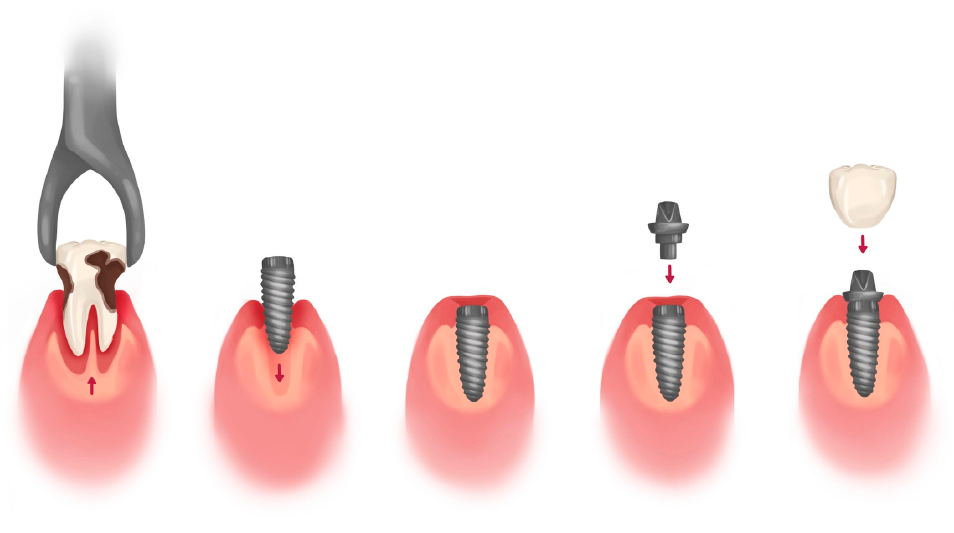
Figure 2. Dental implant surgery phases. With permission from AuthorityDental CC 2.0.